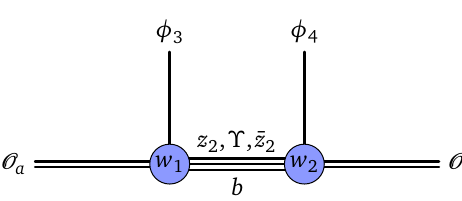
Figure 7 : Four-point function obtained from OPE limit on legs a and c of a six-point function in comb channel. Fields at legs a and c are Symmetric Traceless Tensors, while the exchanged field is a Mixed-Symmetry Tensor with two spin